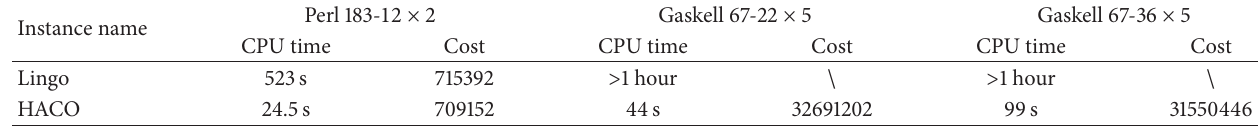
Table 8: Comparisons between HACO and Lingo.